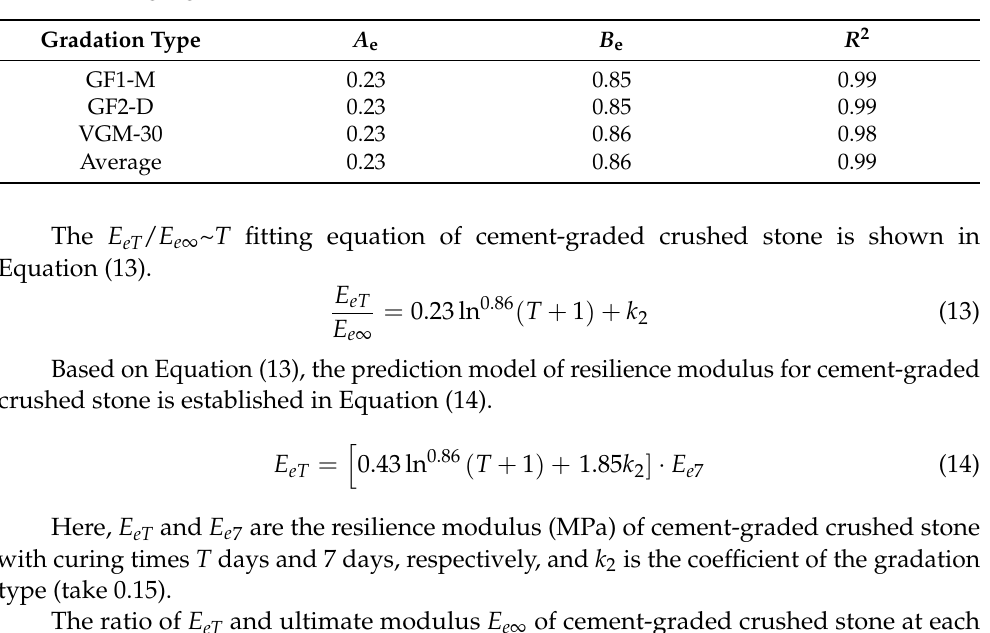
Table 11. Fitting regression coefficients of E eT /E e ∞ ~ T .